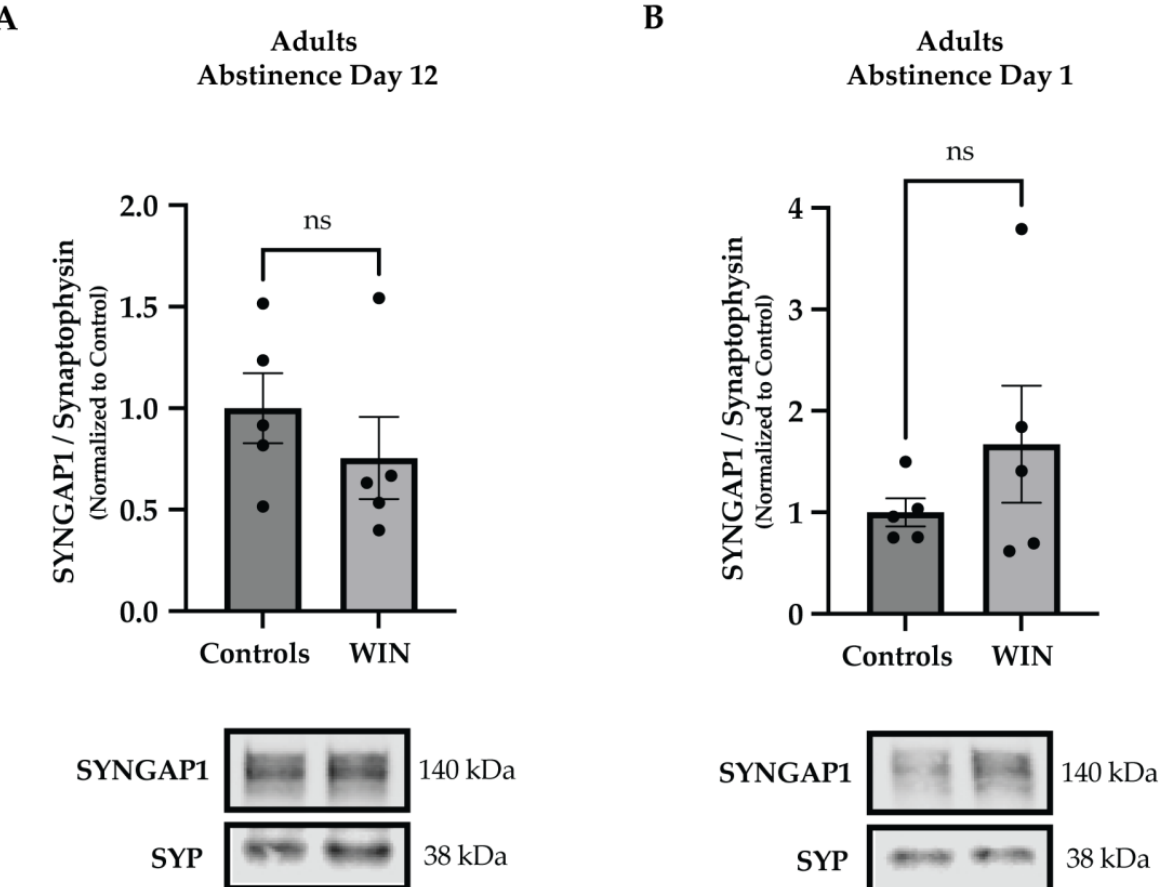
Figure 3. WIN administration in adulthood does not affect synaptic SYNGAP1 levels. Adult male rats were exposed to WIN (PND 77-87) and synaptosomal fractions from the PFC were isolated on drug abstinence days 12 and 1, mimicking the drug administration timeline and the analytic time points applied to adolescents. Western blotting analyses showed no changes in levels of SYNGAP1 on ( A ) abstinence day 12 or on ( B ) abstinence day 1 (n = 5 animals per group), suggesting that the WIN-induced changes in SYNGAP1 are specific to adolescence. Graph data are presented as mean ± SEM. Representative Western blots are shown below the graphs, with the approximate molecular weights of observed band sizes indicated to the right. kDa, kilodaltons; and ns = not significant.